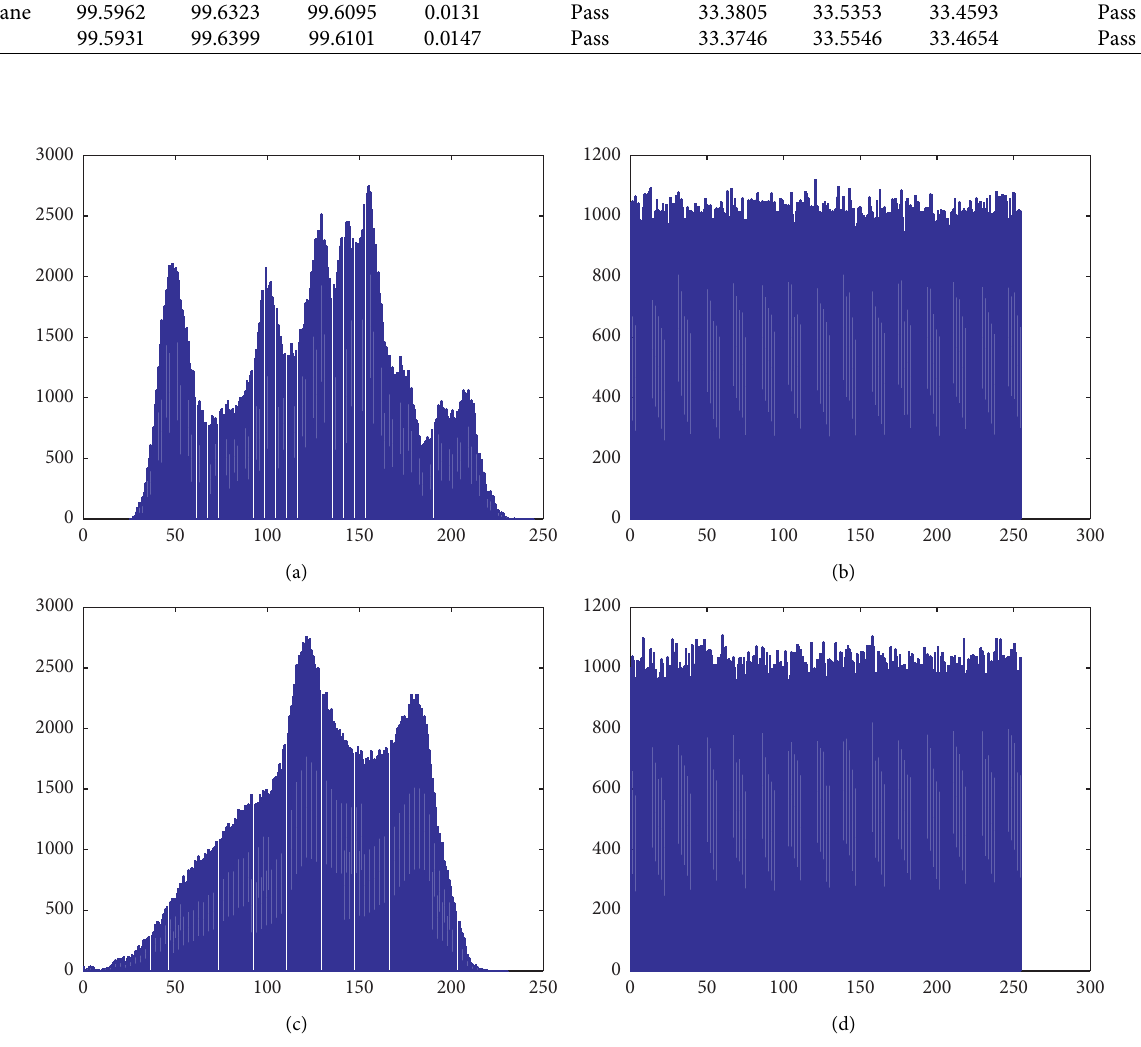
Figure 6: Histograms of (a, c) plain images ”Lena” and “Baboon” and (b, d) their corresponding cipher images. Table 2: Histogram uniformity evaluation by the chi-squared